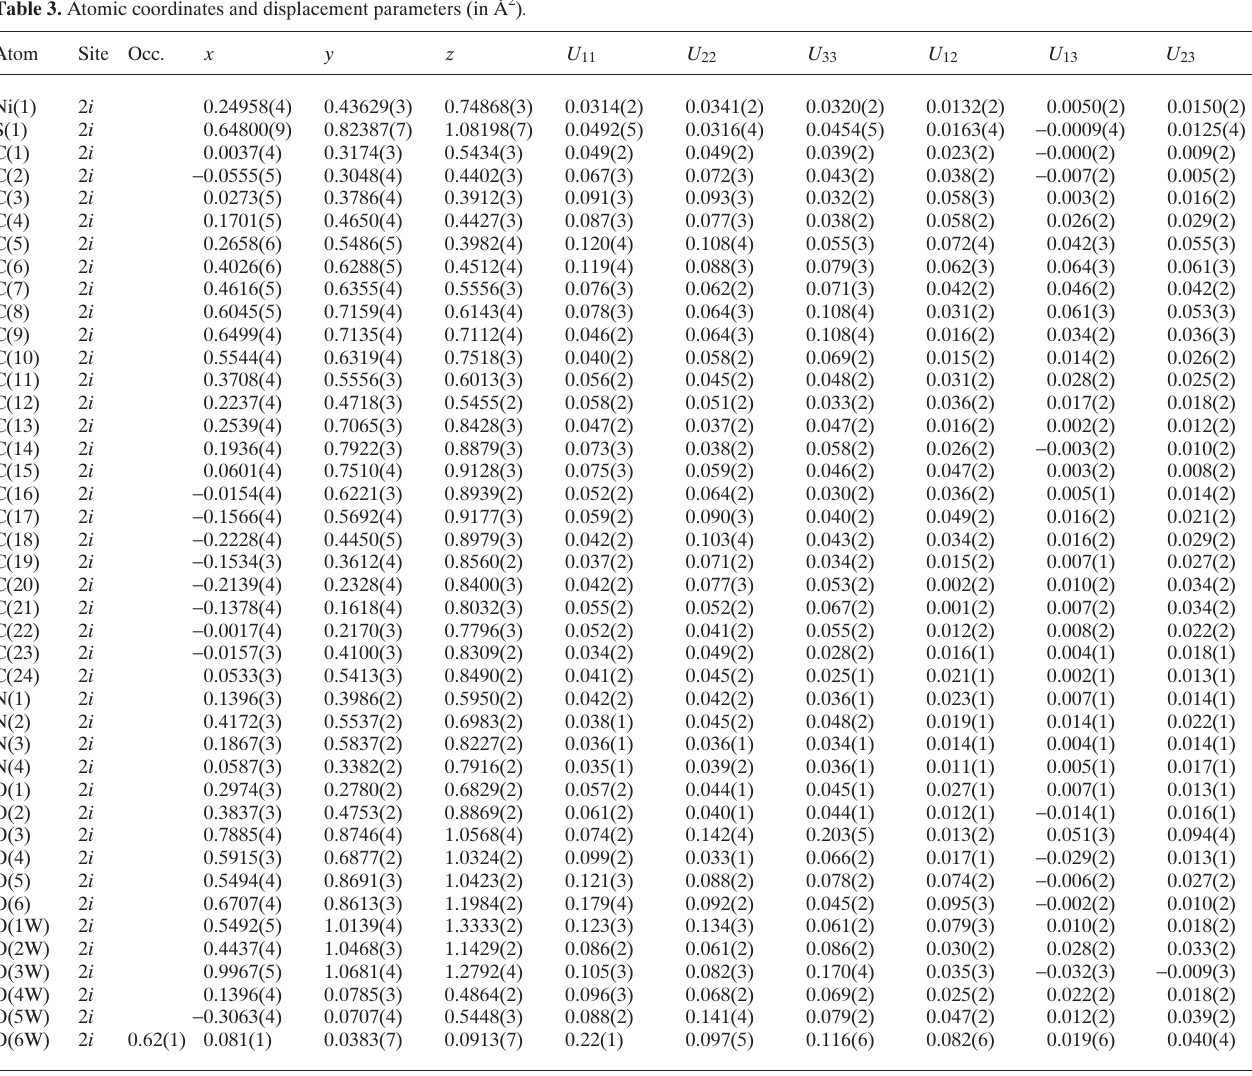
Table 3. Atomic coordinates and displacement parameters (in Å 2 ) .